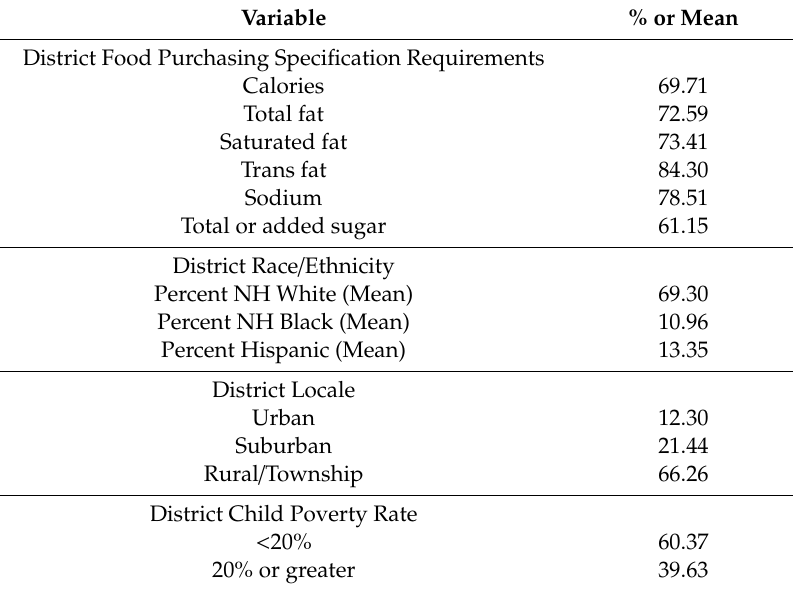
Table 1. Survey-weighted sample